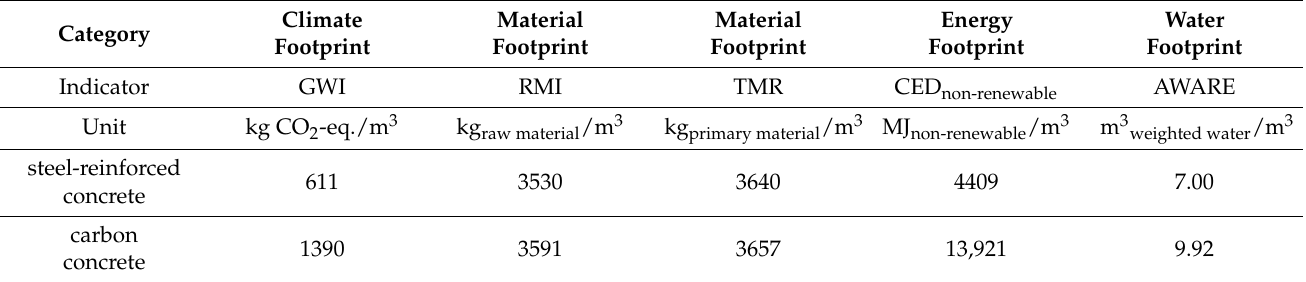
Table 2. Resource and climate footprints of steel-reinforced concrete and carbon concrete per 1 m 3 for the life-cycle phases (A1-A3), (A4-A5), (B1-B4) and (C1-C3); for carbon concrete compressive strength class is C70/85 and mass of carbon fibers is 27.01 kg; for steel-reinforced concrete compressive strength class is C35/45 and mass of steel reinforcement is 69.16